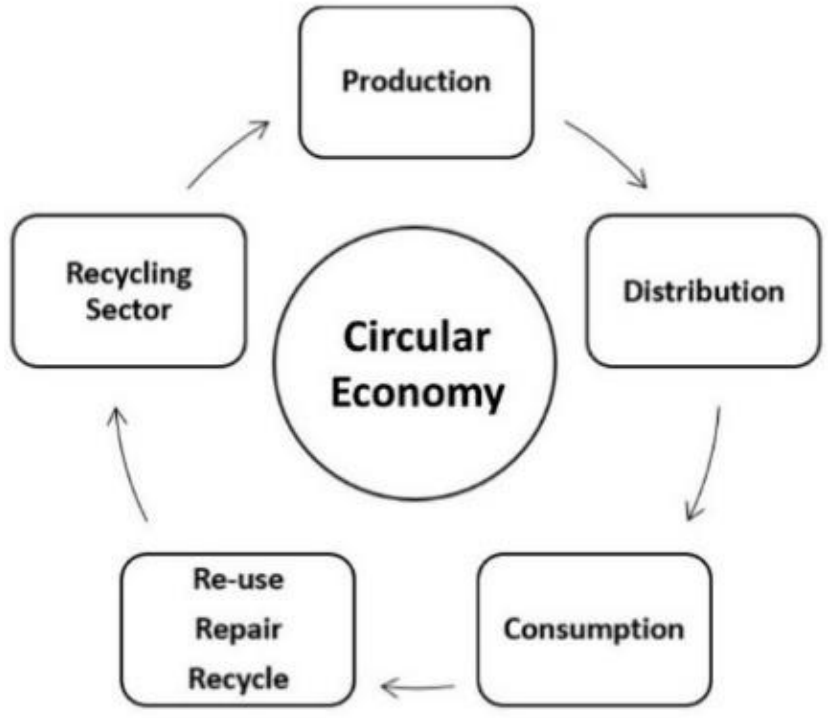
Figure 1. Circular Figure 1. Circular Economy.